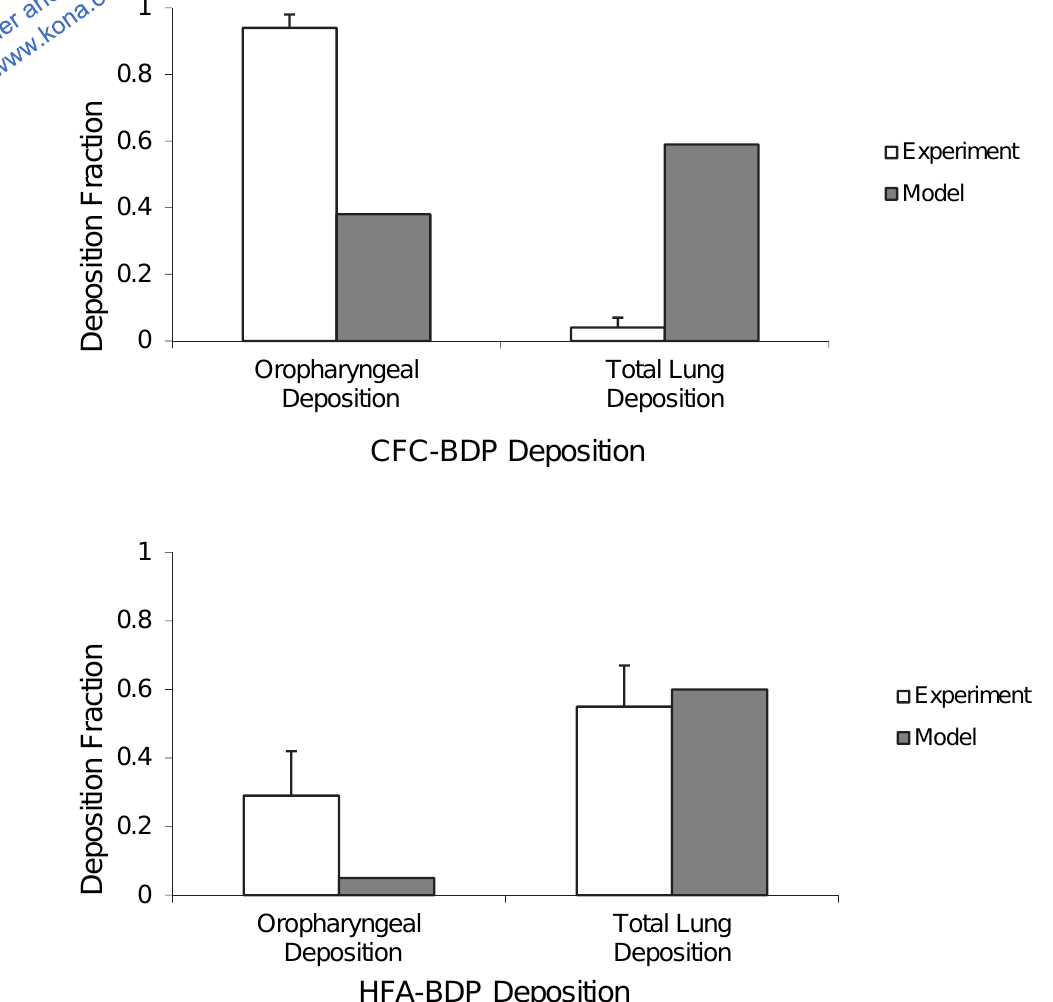
Fig. 7 Comparison of the model predictions of lung deposition to the in vivo experimentally determined lung deposition fractions for CFC based inhalers (upper graph) and HFA based inhalers (lower